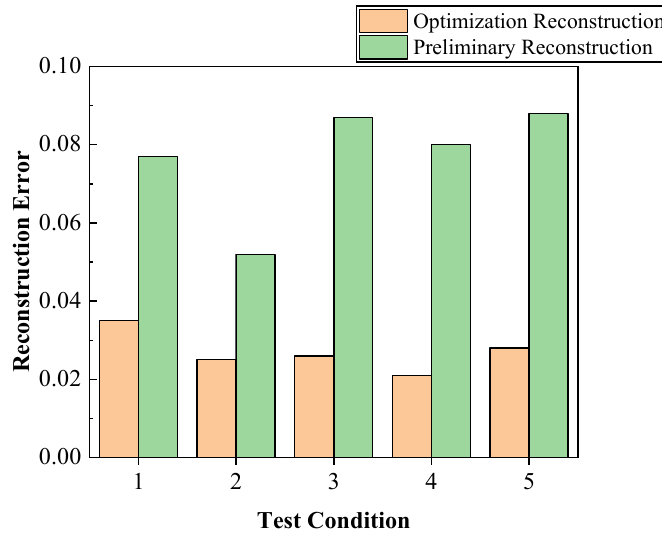
Figure 10. Optimized Effects of Reconstruction Algorithm.